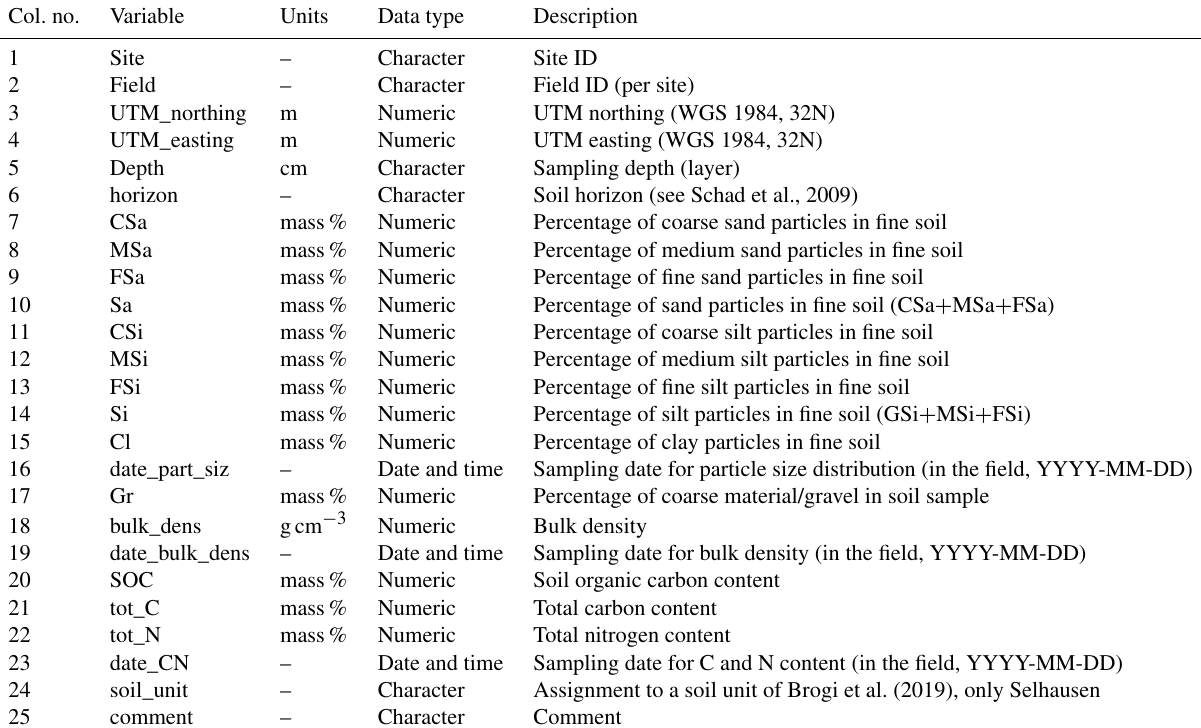
Table A5. Columns of soil data files. For particle size classes see Table A4. Col. no.